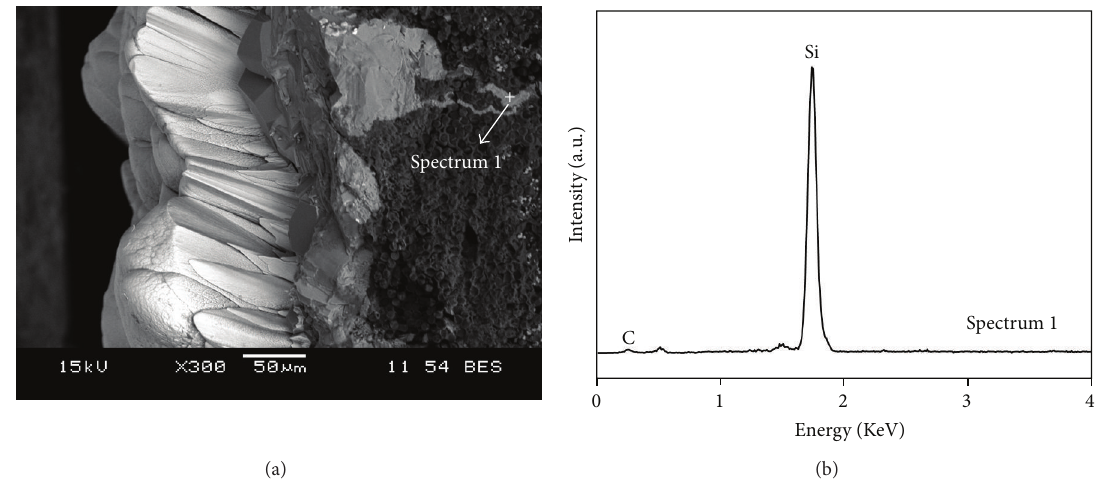
Figure 5: (a) Cross-section micrograph and (b) EDS result of the SiC/Ti6Al4V coatings.